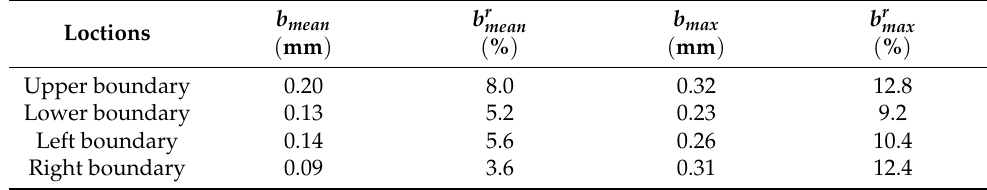
Table 10. The error statistics of each part of the